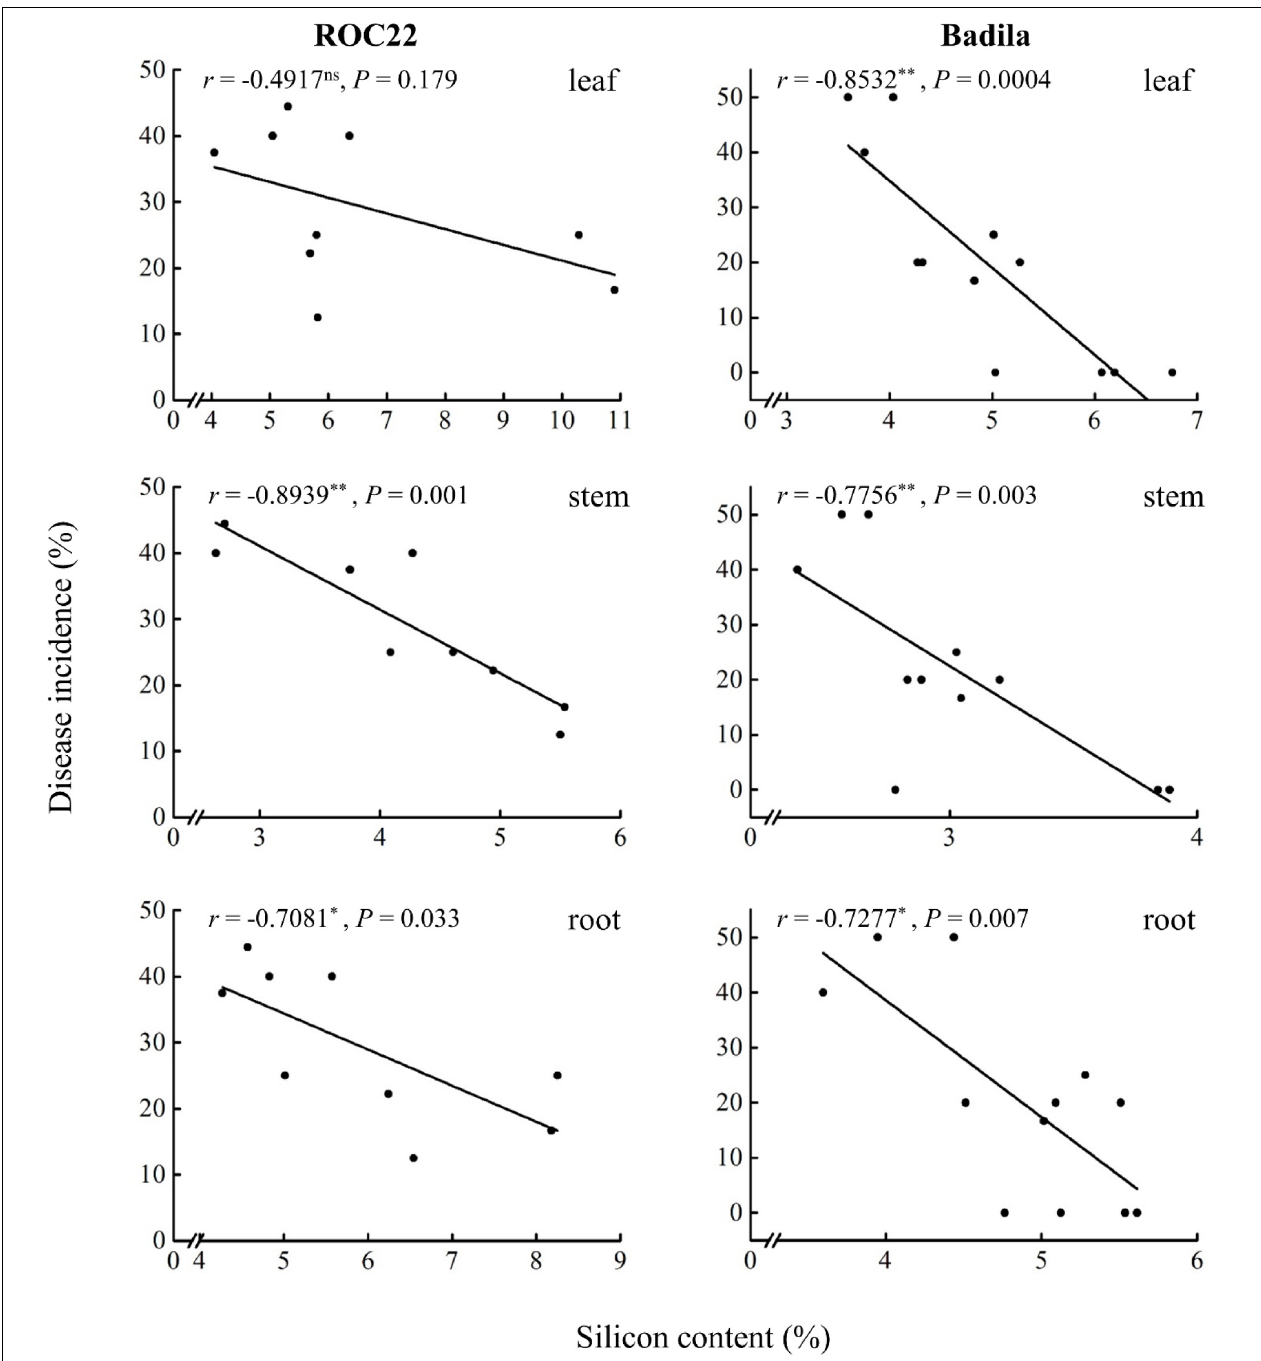
FIGURE 2 | Correlation between silicon content in the leaves, stems, and roots of sugarcane and smut incidence. Levels of correlation: ns, non-significant; * ≤ 0.05 and ** ≤ 0.01. r , correlation coefficient. P , P -value.